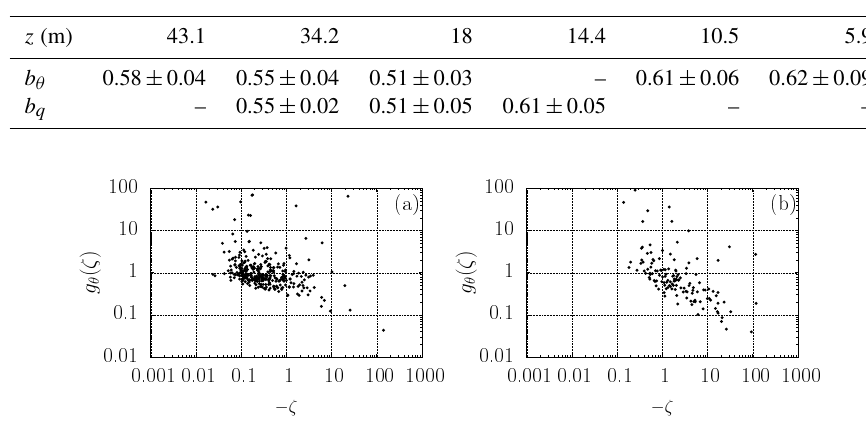
variance of temperature, N . From the latter and (cid:15) , the value of g θ in Eq. (7) was calculated. It is plotted against ζ for the two levels in Fig. 3a and b. There is a clear pattern of de- creasing g θ with ζ , but there is still a large scatter typical of roughness sublayer